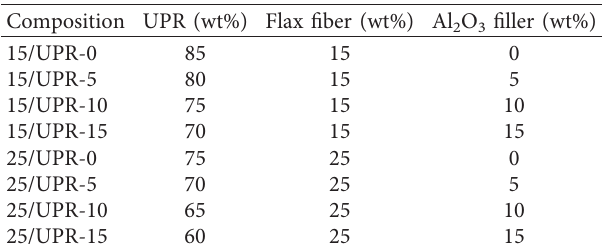
Table 5: Weight percentage proportions to fabricate the composite used for property